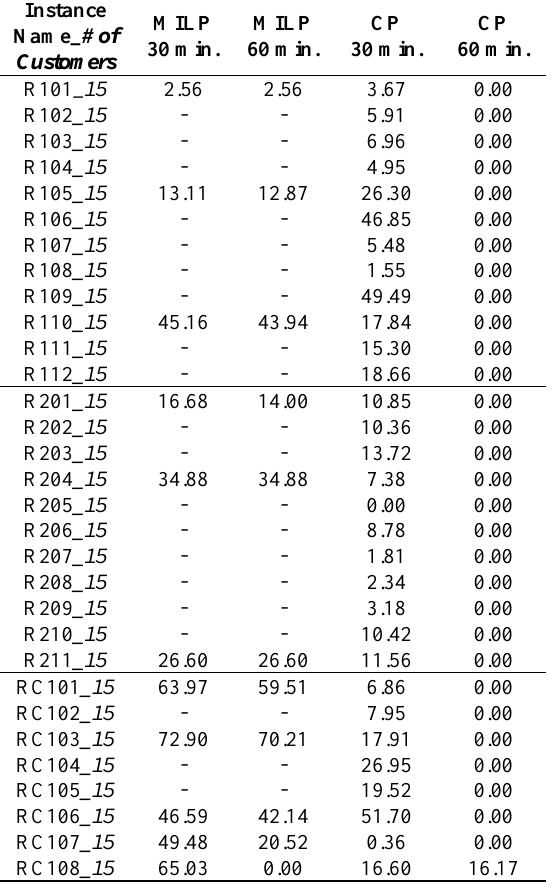
Table A5. The RPD results for instances with 15